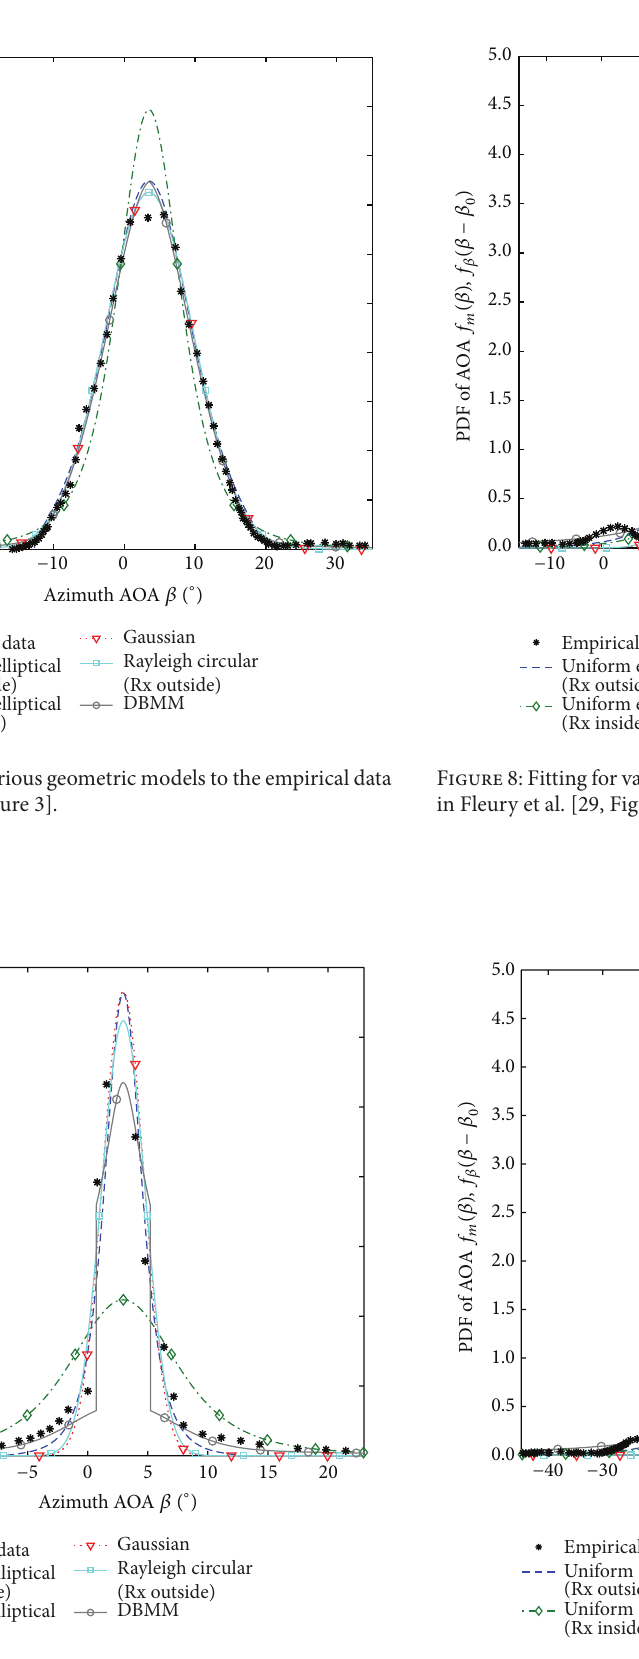
Figure 7: Fitting for various geometric models to the empirical data in Takada et al. [26, Figure 4 ].